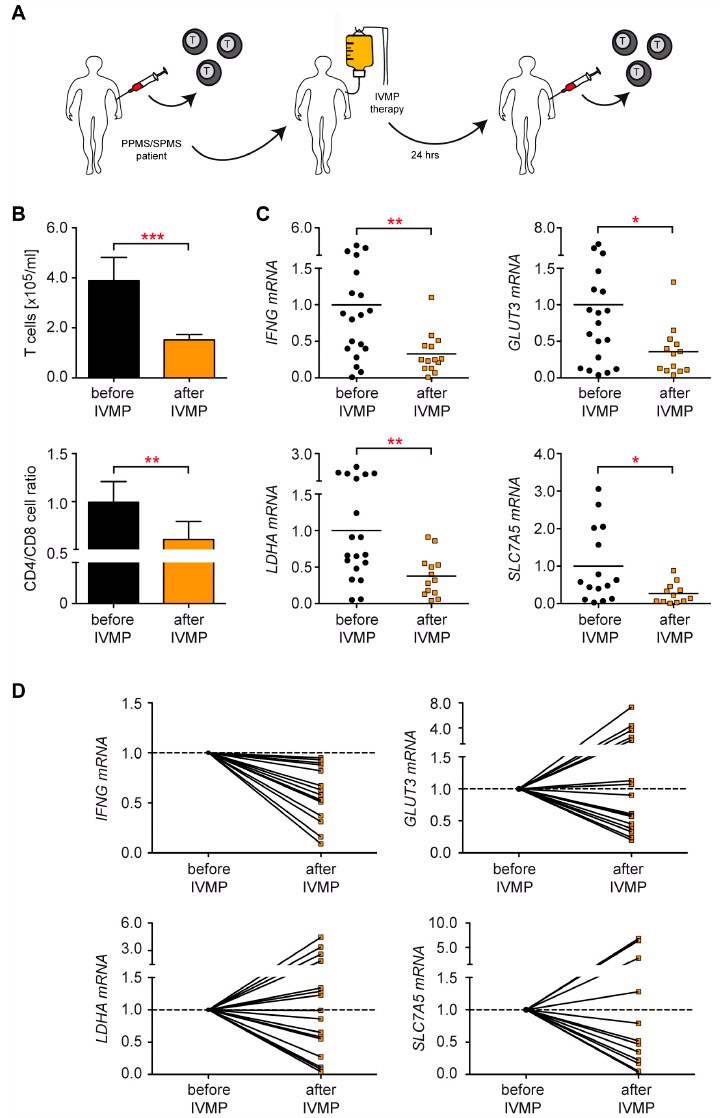
Figure 7. Comparison of metabolic gene expression in human peripheral blood T cells obtained from MS patients before and after IVMP therapy. ( A ) Setup of the experimental model. ( B ) T cells were purified from blood collected from PPMS and SPMS patients immediately before IVMP therapy and 24 h later; stained with CD3, CD4, and CD8 antibodies; and analyzed by flow cytometry. Absolute numbers of CD3 + T cells per ml of blood (upper panel) and the ratio between CD4 + and CD8 + T cells (lower panel) are depicted as the mean ± SEM. N = 18/17. ( C ) T cells were purified from blood sam- ples as described for panel B. Gene expression was determined by RT-qPCR, and relative mRNA levels were calculated by normalization to the housekeeping gene 18SRNA. N = 12–19. The average expression in T cells isolated before IVMP administration was arbitrarily set to 1 for each gene. Each dot corresponds to one patient. Statistical analysis in panels B/C was performed by one-way ANOVA followed by a multiple comparisons test. Levels of significance: ∗ p < 0.05; ∗∗ p < 0.01; ∗∗∗ p < 0.001. ( D ) Presentation of the RT-qPCR results from panel C individually for each patient. N = 13– 16. Gene expression in T cells isolated before IVMP infusion was arbitrarily set to 1 for each indi- vidual patient, and the relative gene expression after therapy was calculated in relation to it. Subsequently, we analyzed gene expression in T cells purified from the patient’s pe- ripheral blood. IVMP therapy not only reduced the mRNA levels of IFNG but also GLUT 3, SLC7A 5, and LDHA , confirming that therapeutically applied GCs repress genes involved in the energy metabolism of T cells in MS patients with a progressive disease course (Fig- ure 7C). Considering the previously described immunological differences between PPMS